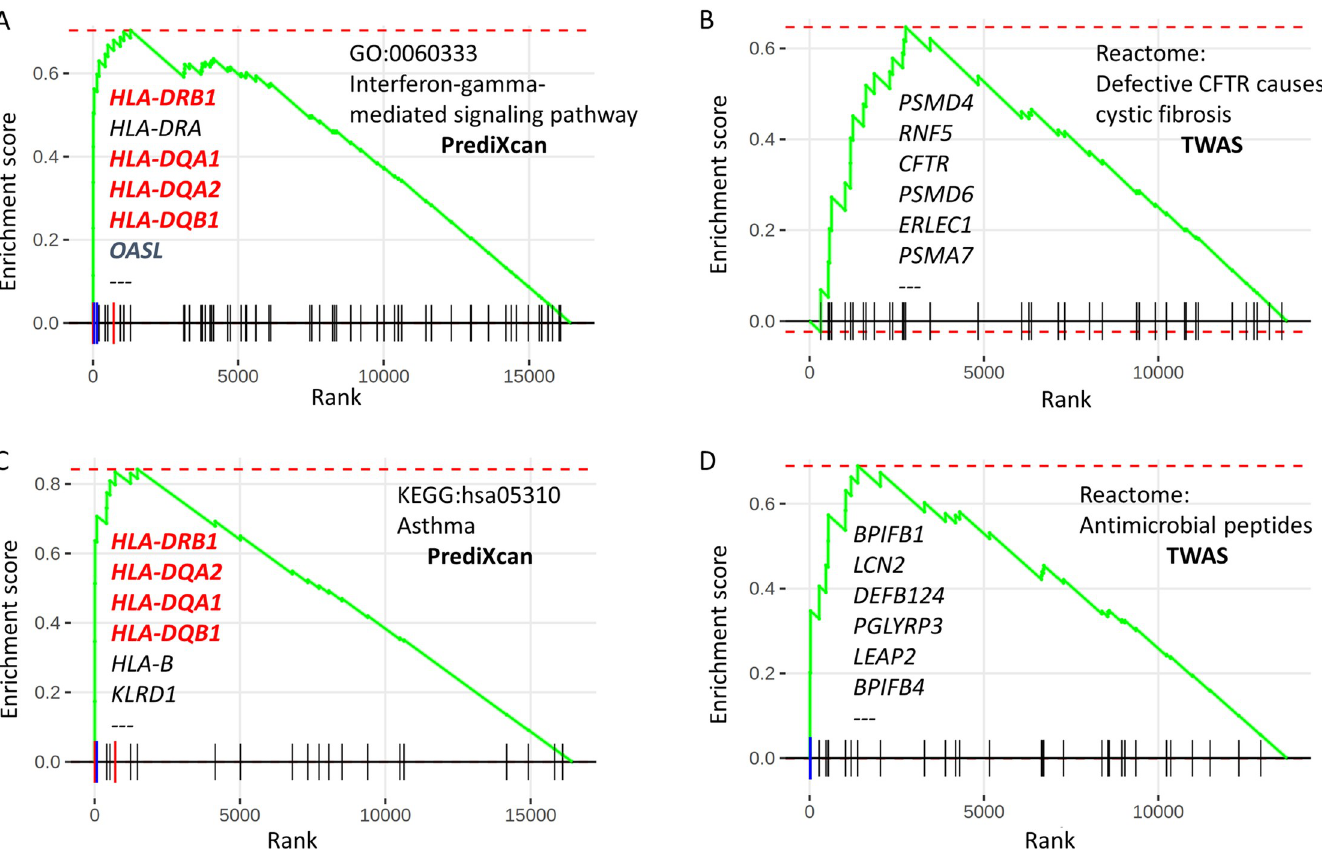
Fig 6. Gene set enrichment plots. Gene set enrichment analyses (GSEA) were performed and enrichment plots were generated for selected gene sets using the Bioconductor R package, fgsea . For each enrichment plot, the horizontal black line at the bottom represent p-value ranks of protein-coding genes with most significant p-value rank on the left. The vertical bars represent individual genes in a gene set and their ranks. The green curves represent the cumulative enrichment score (ES), and the red horizontal dashed lines denote minimal (often 0) and maximal scores. Listed genes represent the leading edge with increasing ES, that contribute to the overall enrichment of the gene set. Panel A and C are GSEA results from PrediXcan platform, while B and D from TWAS. Particular gene sets shown are from GO biological process (A), and Biosystems (C–KEGG, B, D–Reactome).